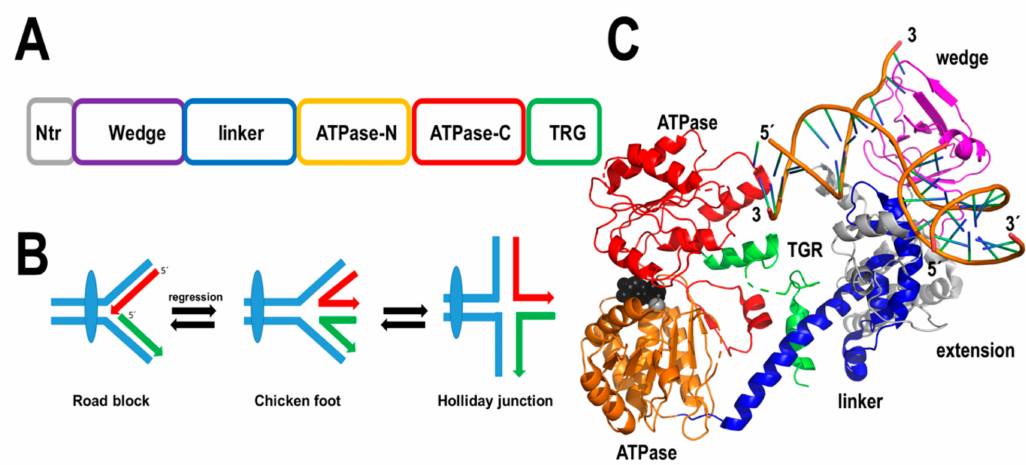
Figure 8. Plants harbor a RecG ortholog. ( A ) AtRecG presents the same domain organization of bacterial RecG, plus the addition of an N-terminal organellar targeting sequence. ( B ) RecG remodels halted replication forks by promoting fork regression (chicken foot structure) that is converted to a Holliday junction. ( C ) Crystal structure of T. maritima RecG illustrating its modular assembly.